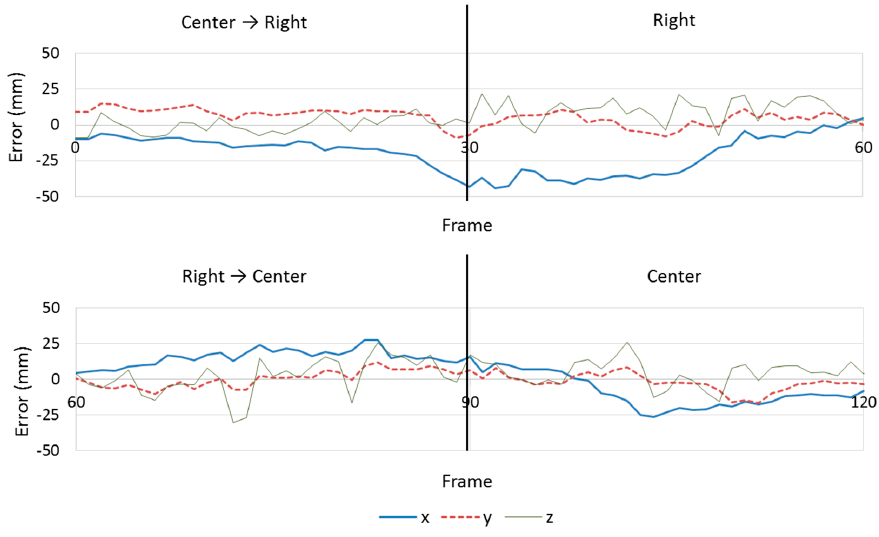
Figure 8. Translation errors when the head moved horizontally.